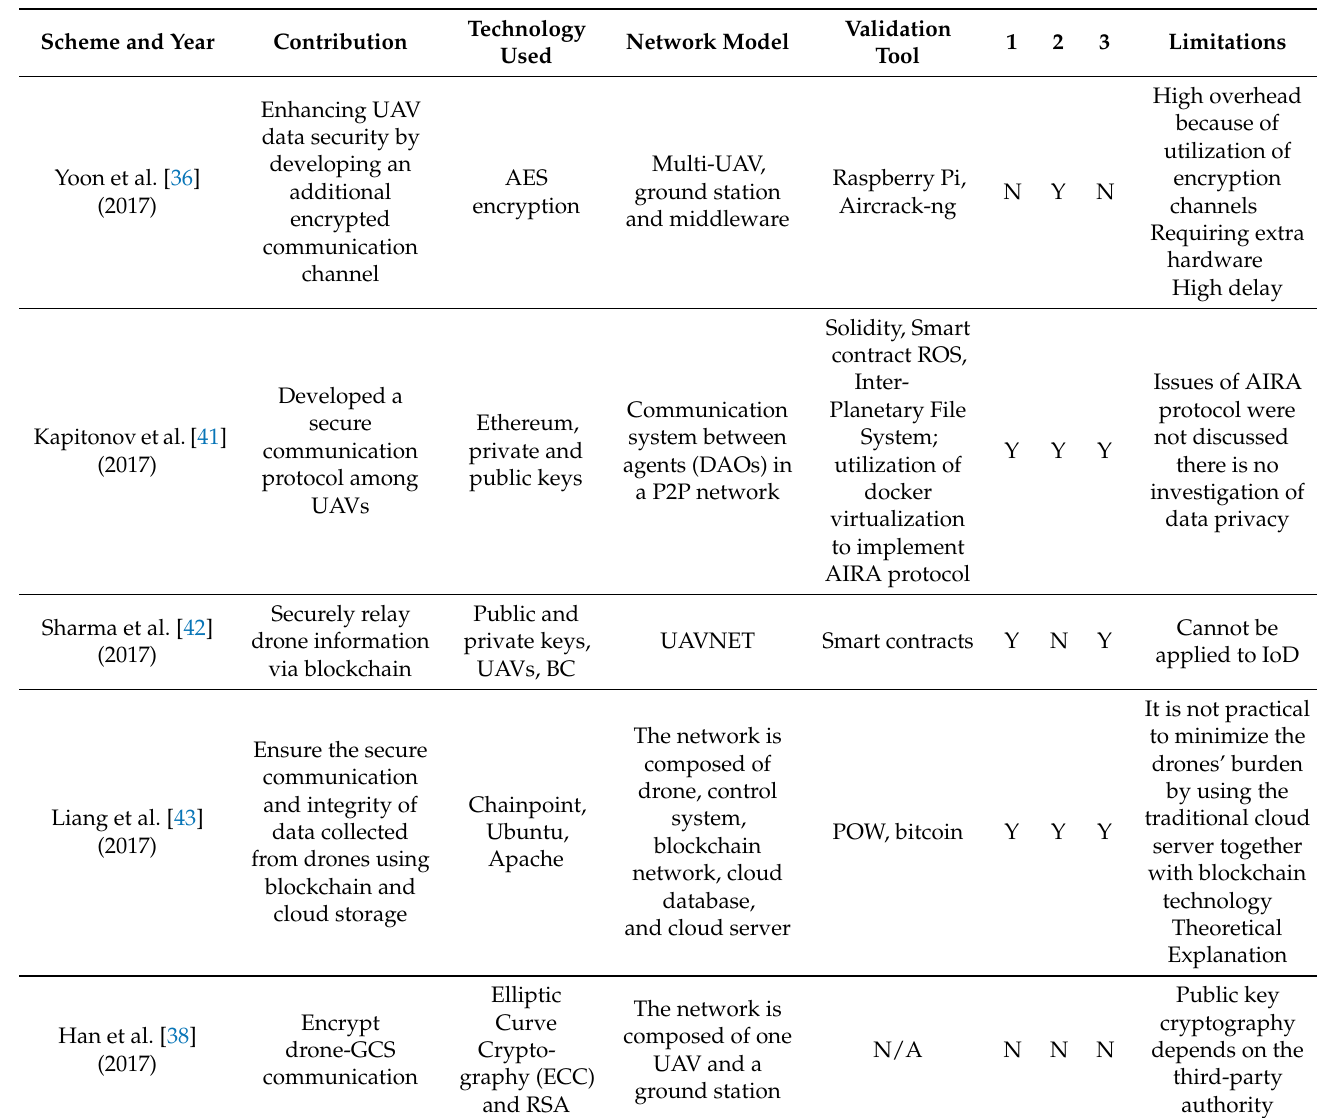
Table 1. Summary of related